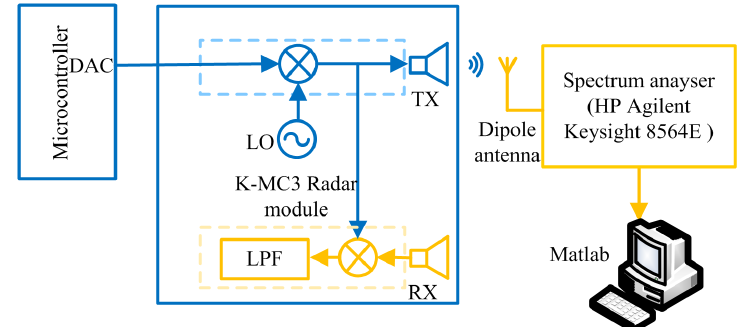
Figure 11. The block diagram of the experiment to verify the power spectral density (PSD)